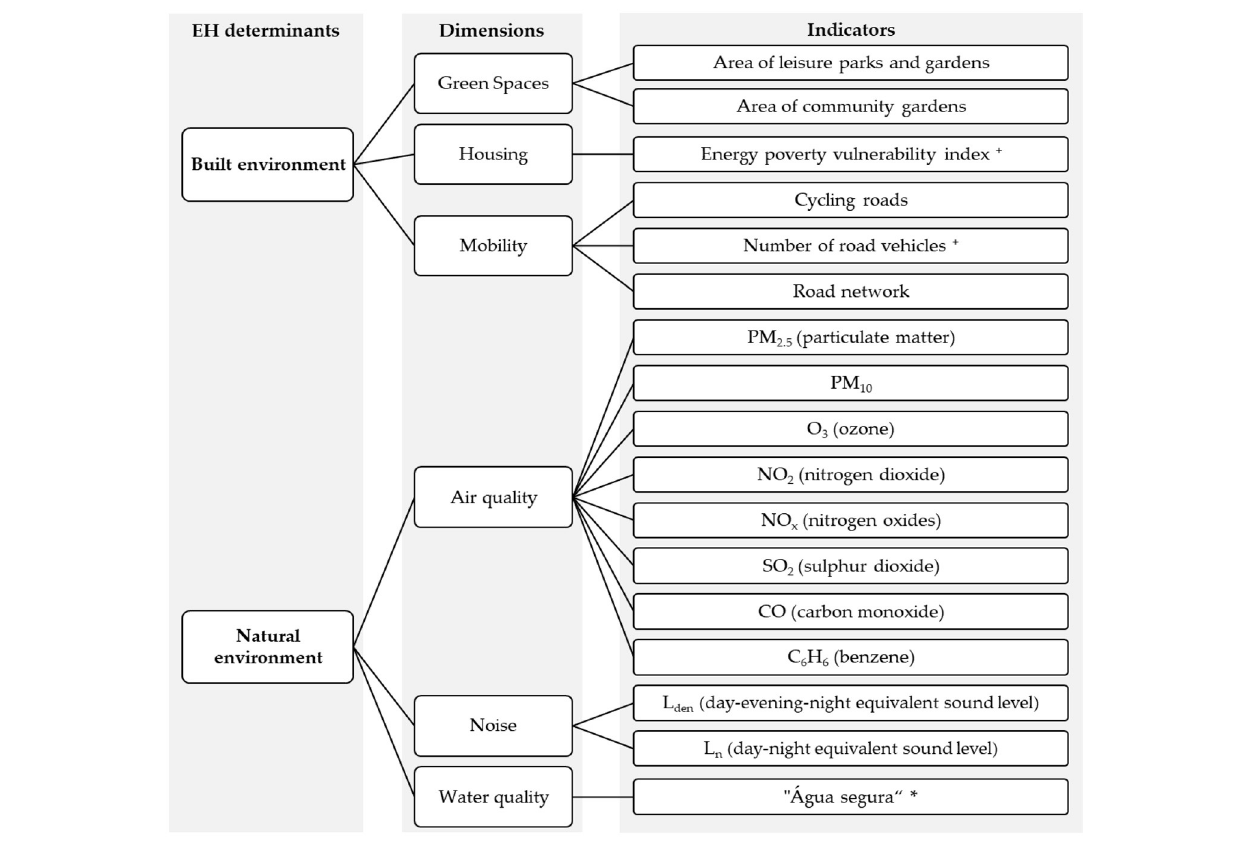
FIGURE 2 | Indicators selected and validated as relevant to monitor EH in Lisbon city in Salgado et al. (5), organized by EH dimensions and determinants. + indicators without collected data in Lisbon. * Portuguese indicator that measures the percentage of compliance with the parametric values established in the legislation.